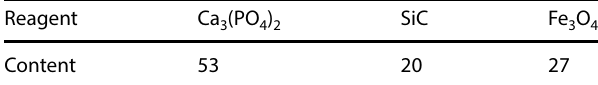
Table 3 Raw material ratio